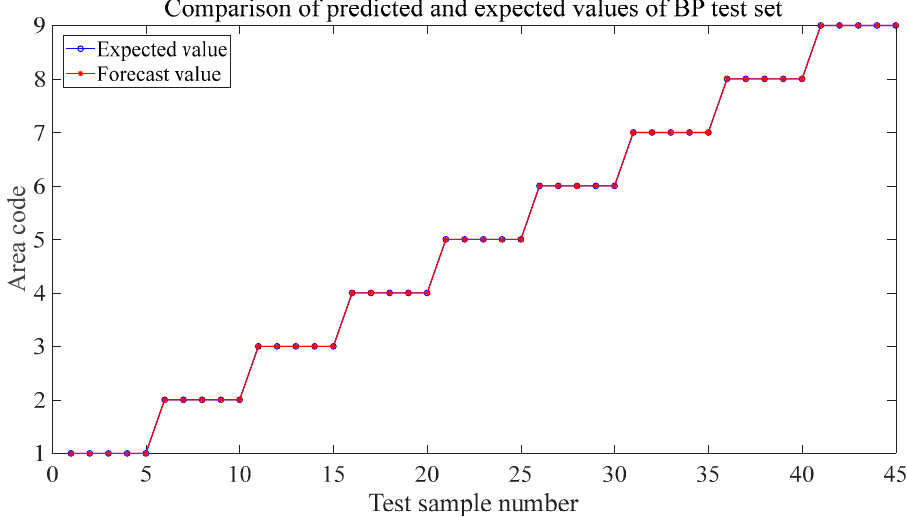
Figure 15. Predicted results when the center frequency is 200 kHz.